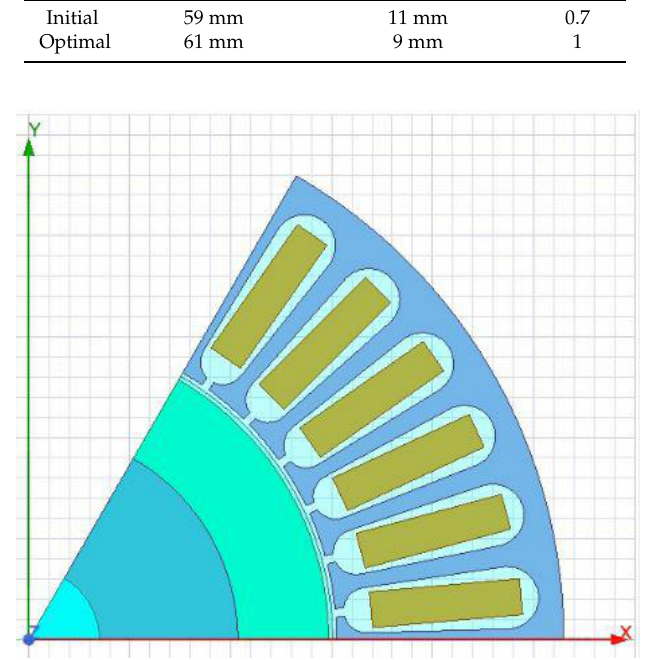
Figure 17. Optimal model.